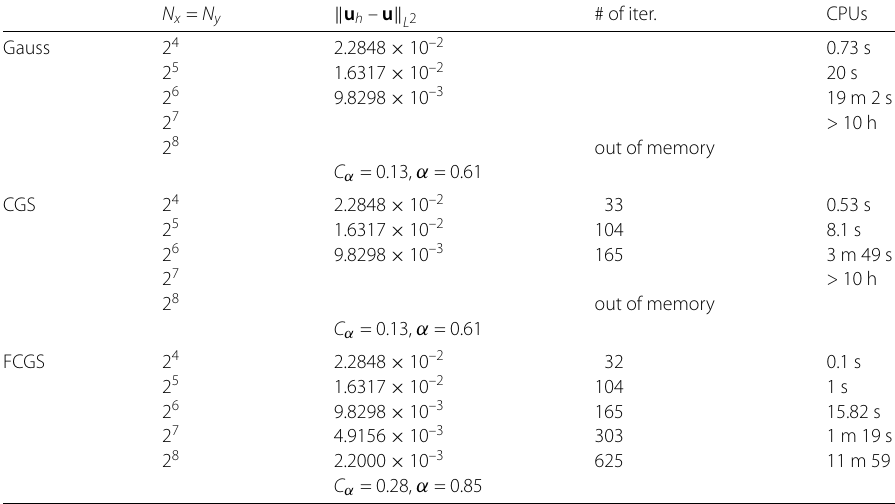
Table 2 Performance of FCG, CG, and Gauss while s = 3/8 N x = N y